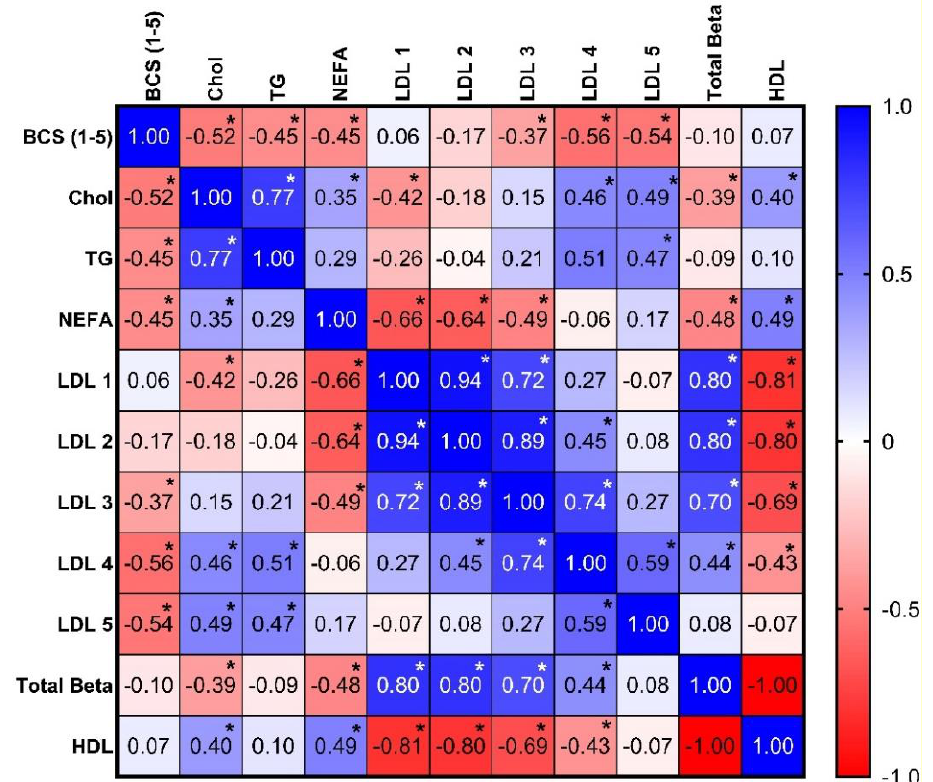
Figure 2. Summative data of the Lipoprint ® fractionation for all donkeys, displaying the median (bar) third and first quartiles (box), and 2.5 – 97.5% (whiskers) outliers are shown as individual points. The percent of total lipoproteins is generated from the area under the curves from the densitometry plots.